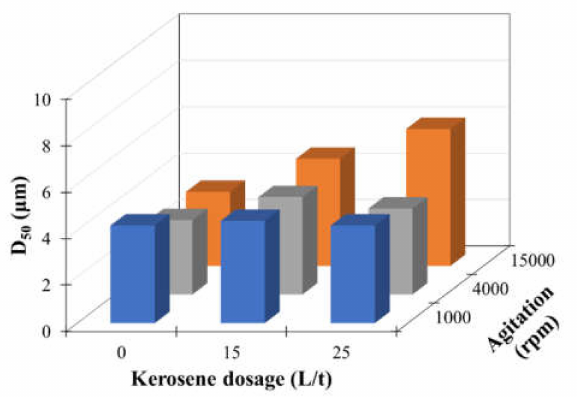
Figure 5. E ff ects of kerosene dosage and agitation speed on the median diameter (D 50 ) of agglomerates (KAX 200 g / t). KAX—potassium amyl